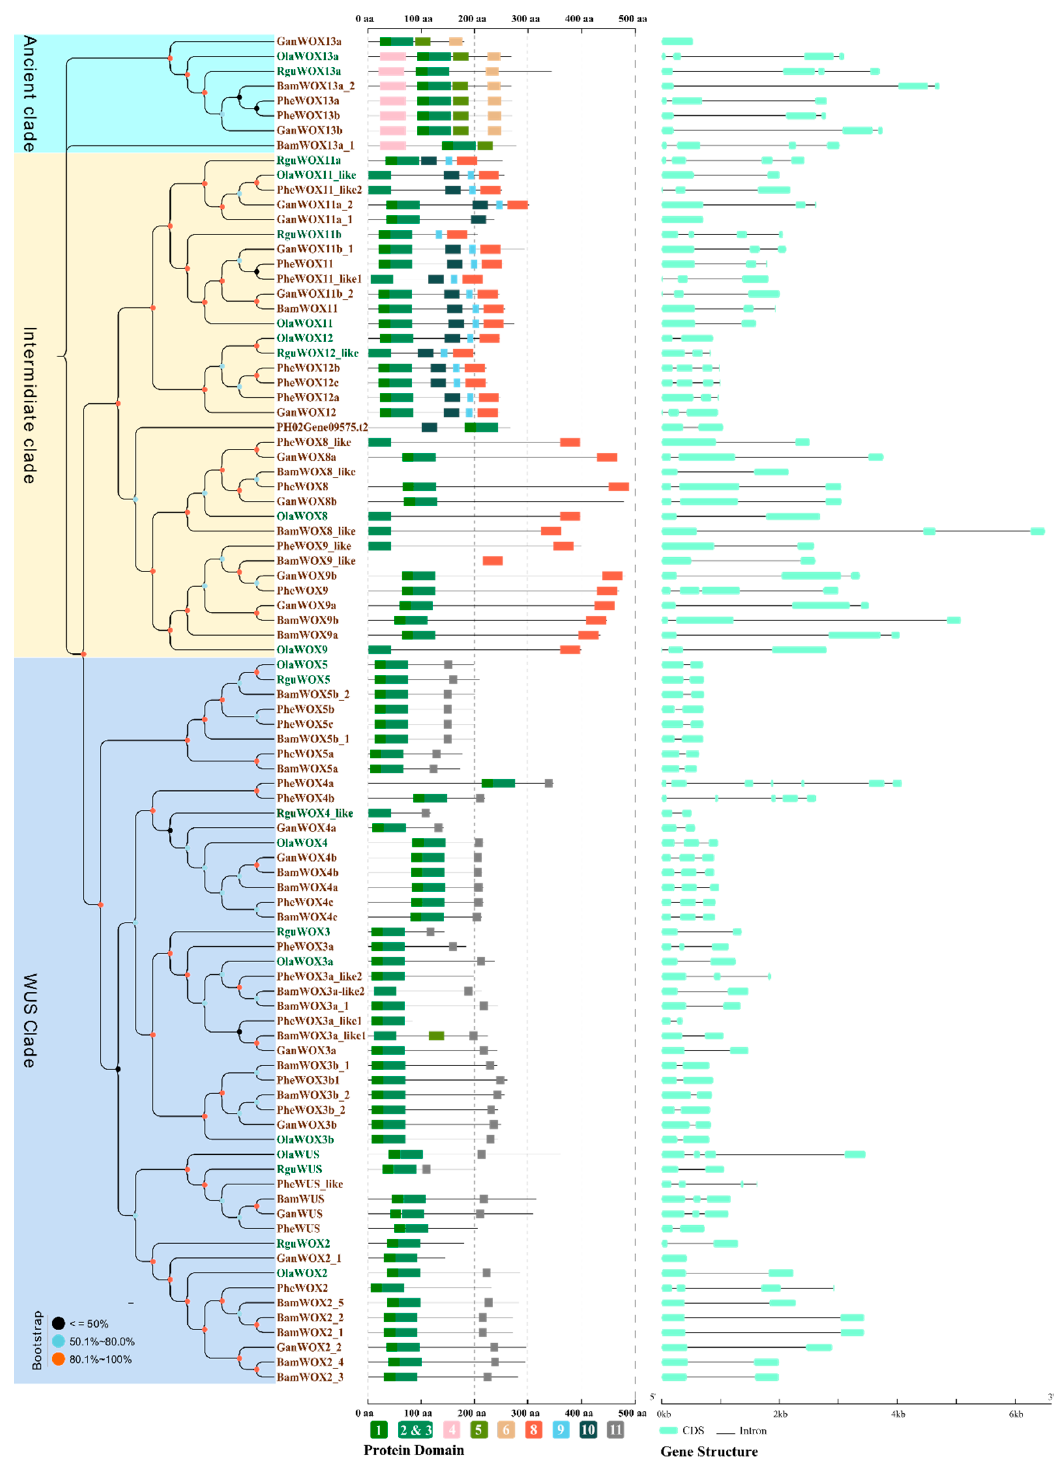
Figure 3. The phylogenetic tree of Bambusoideae WOXs . The neighbor-joining tree was constructed by the full-length CDS of Bambusoideae WOXs with bootstrap assessment of 1000 replicates. Each clade was assigned a different colored background. Green leaves of the phylogenetic tree stand for WOXs of herbaceous bamboos. Brown leaves of the phylogenetic tree stand for WOXs of woody bamboos. The protein domains and gene structures are drawn following each WOX . The name of each domain is the same as in Figure 1.